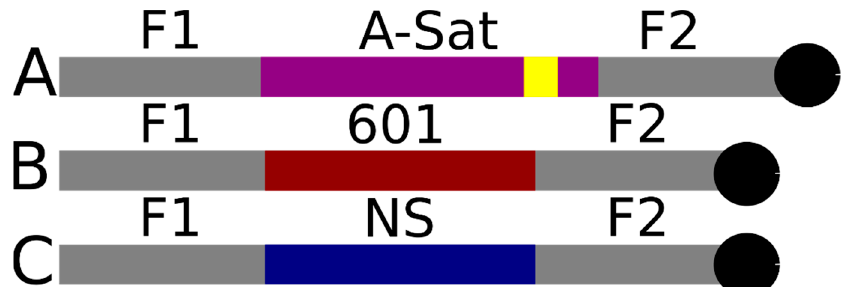
Figure 1. Schematic representation of the substrates used. Schematic ( A ) represents the α -satellite substrate. Schematic ( B ) represents the 601 substrate. Schematic ( C ) represents the non-specific sub- strate. F1 is 114 bp and F2 is 125 bp on substrate ( A ). F1 is 113 bp and F2 is 117 bp on substrates ( B , C ). A-sat represents the α -satellite sequence of 171 bp; the yellow region represents the 17 bp CENP-B box within the α -satellite sequence; 601 represents the Widom 601 sequence of 147 bp; NS represents a non-specific sequence of 147 bp; the black circles represent the biotin label at the end of each template.